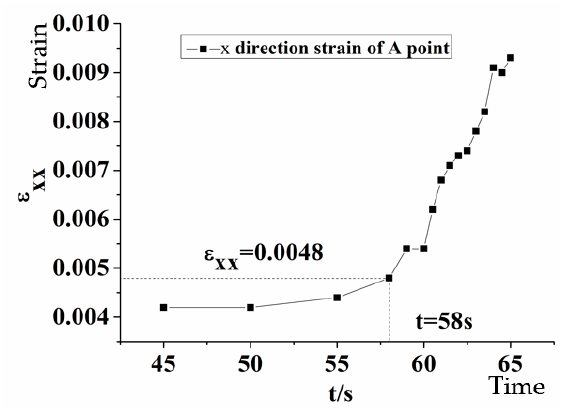
Figure 14. X-direction strain–time relationship at point A (loading rate = 0.3 MPa/s).